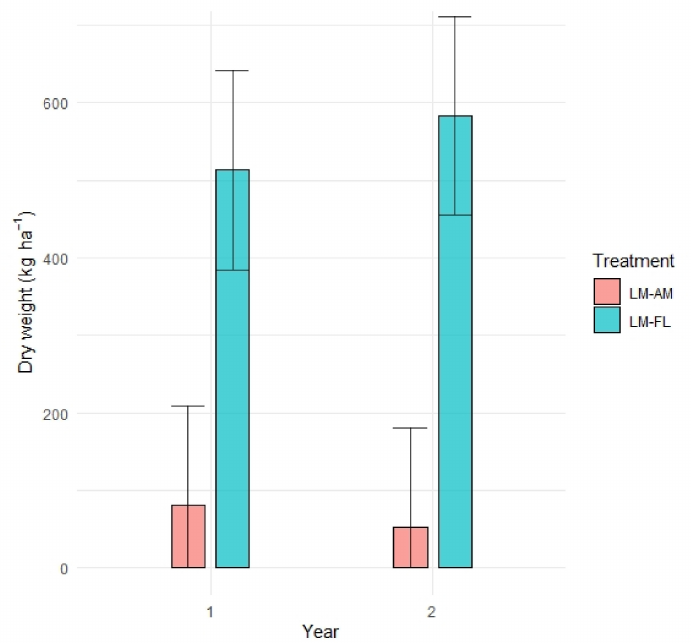
Figure 8. Effect of treatments (LM-FL, LM-AM) and years on the aboveground dry weight of the LM sampled at eggplant harvest time. Error bar represents the upper and lower limits of the 95% confidence